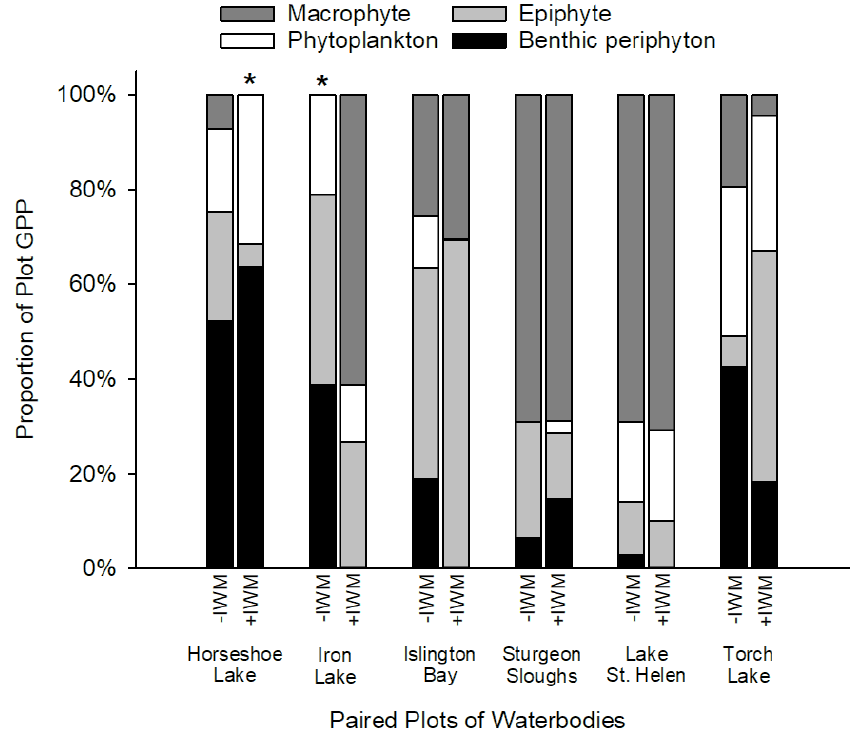
Figure 7. Proportions of plot GPP by epiphyte, phytoplankton, benthic periphyton, and estimated macrophytes in paired + IWM and − IWM plots. Proportions of GPP from macrophytes that were set to zero are indicated with (*); see related methods in Section 2.7.